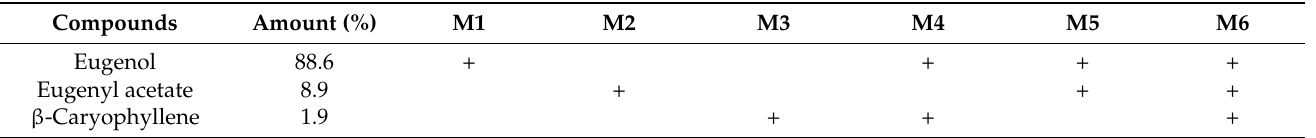
Table 1. Components of the synthetic volatile blends comprising of the clove essential oil compounds used in olfactometer tests for pear psyllids ( Cacopsylla pyri and C. pyricola ). Compounds